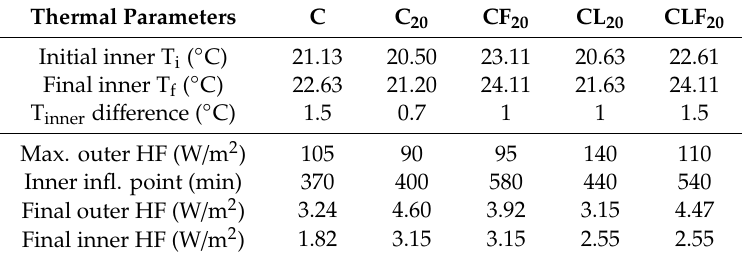
Table 5. Summary of temperature and heat flux main results on both sides of the brick wall enclosure with a PCM cement-lime mortar layer during a heating